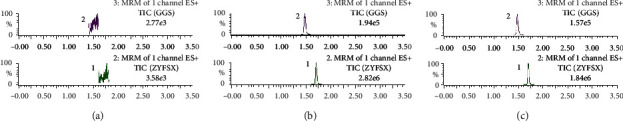
Typical chromatograms. (a) Blank tissue homogenate; (b) blank tissue homogenate spiked with LVFX and IS; (c) rat tissue homogenate collected at 30 min after oral administration of LVFX. (1) LVFX; (2) puerarin.